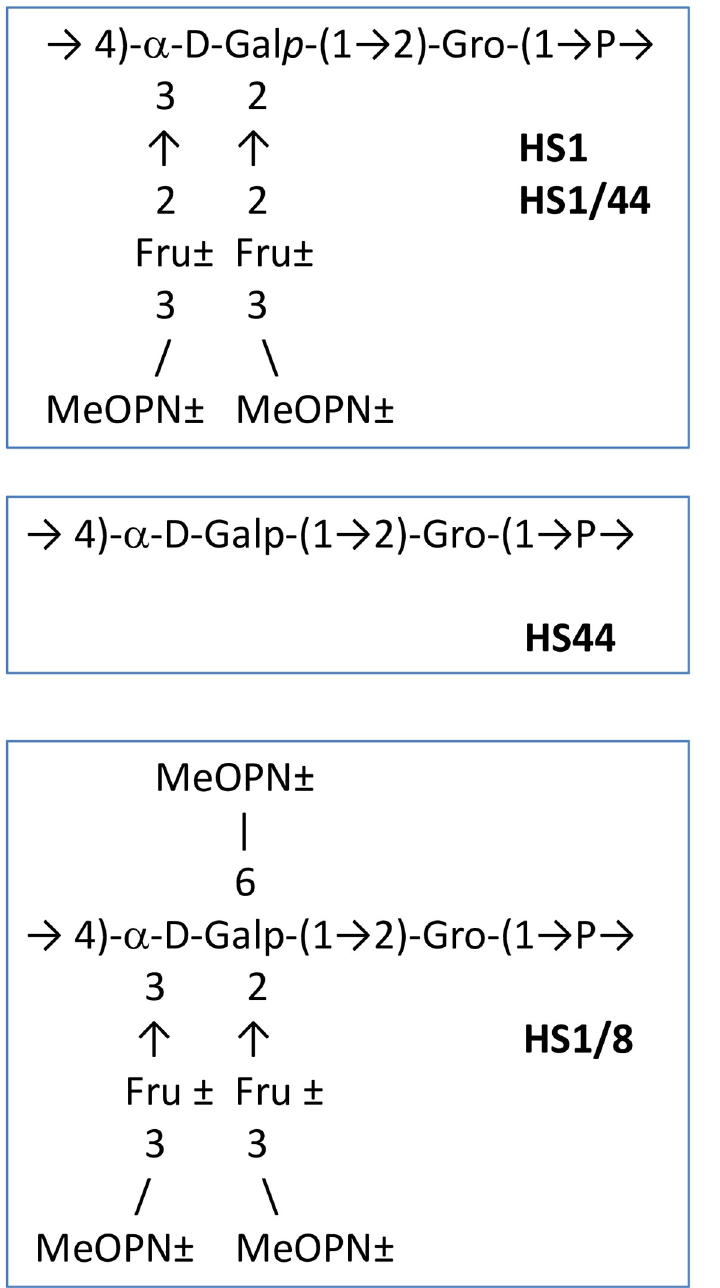
Fig 1. Structure of teichoic acid-like capsules among the HS1